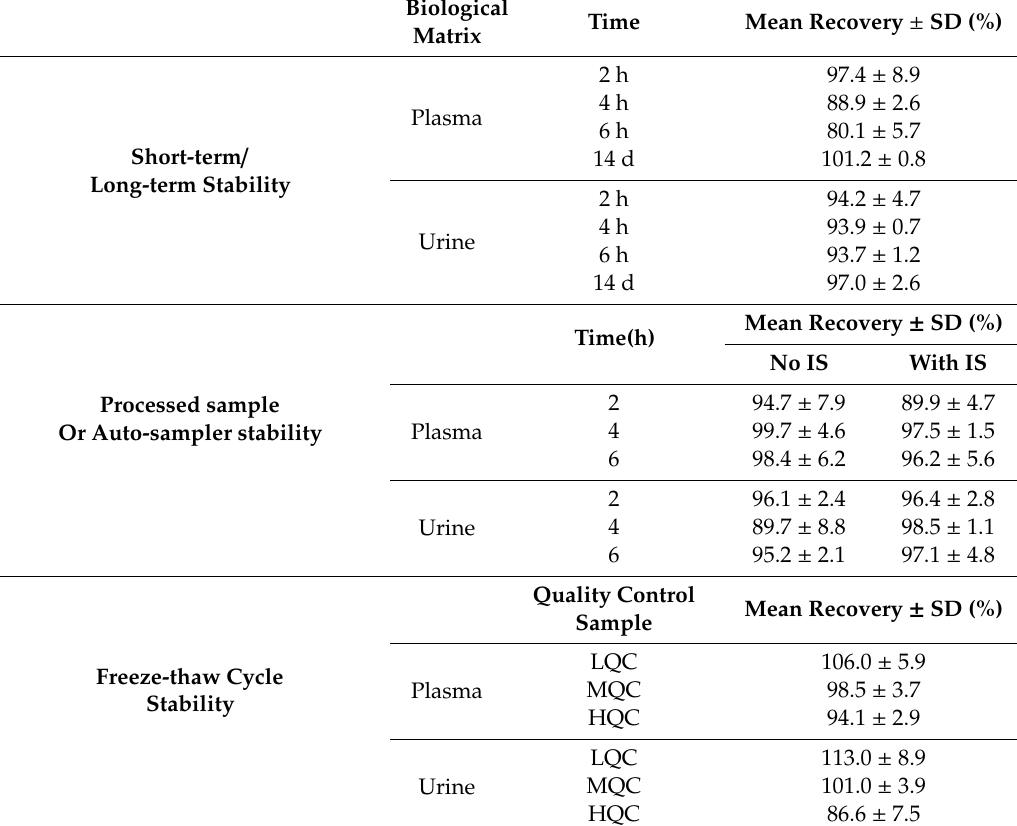
Table 4. Stability of GMC1 in samples for LC-MS / MS analysis ( n = 3; mean ( ±